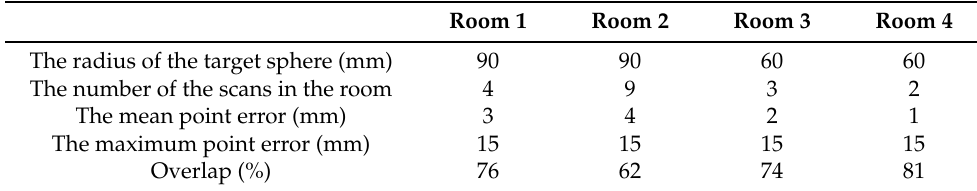
Table 2. The registration results of the TLS of the